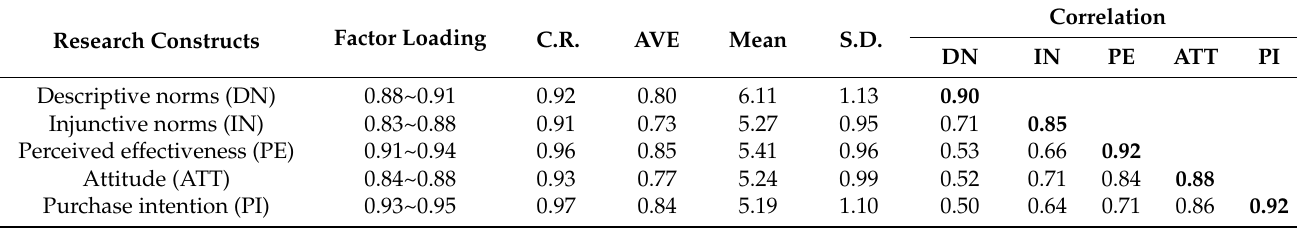
Table 2. Correlations between research constructs.